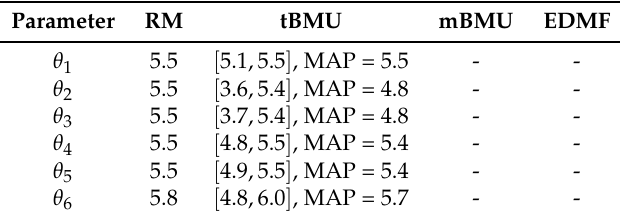
Table 8. Updated parameter ranges (posterior distributions) for Scenario 1. mBMU failed to find a starting point, while EDMF falsified the entire initial model set. MAP refers to the maximum a-posteriori estimate.